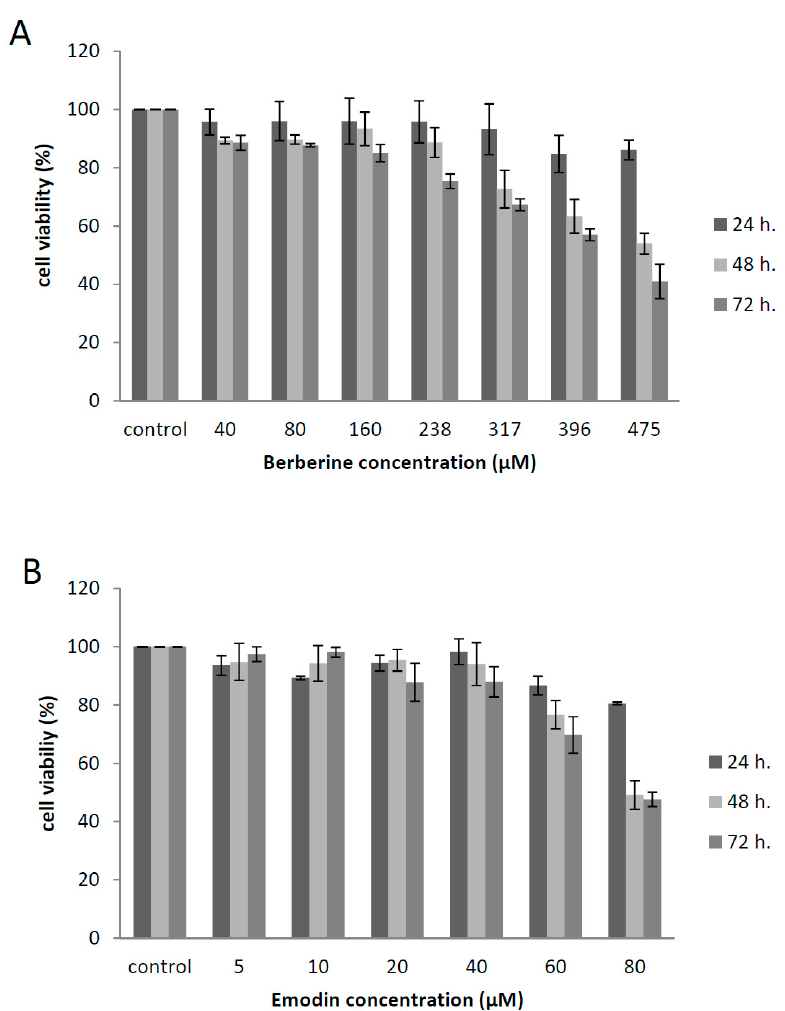
Figure 1. Viability of emodin- and berberine-treated Vero E6 cells. Cells were incubated with different concentrations of emodin ( A ) or berberine ( B ) and cell viability was evaluated after 24 h, 48 h, and 72 h.